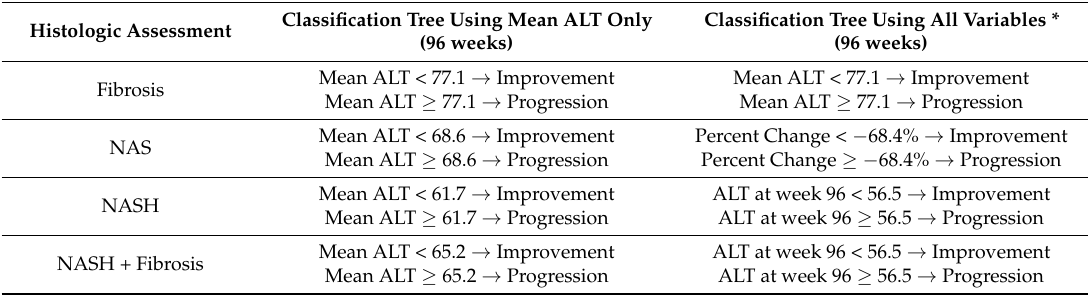
Table 3. Classification trees.